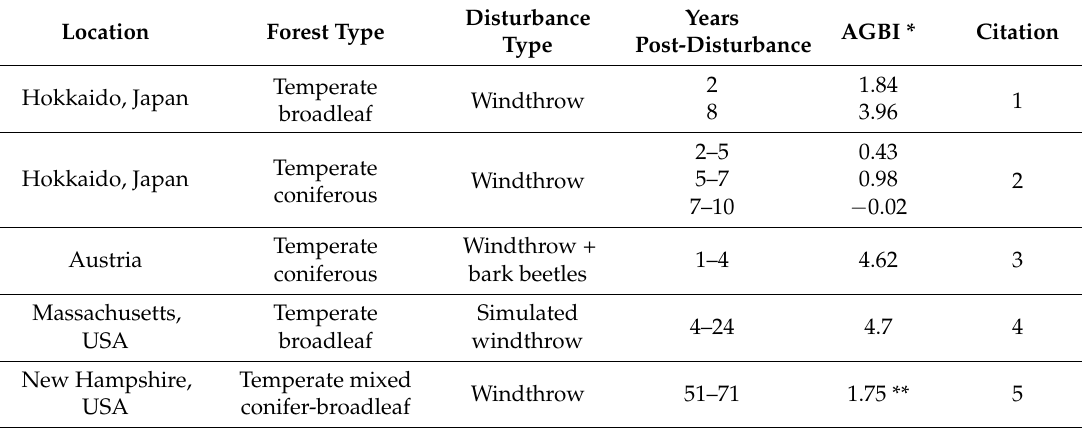
Table 2. Aboveground biomass increment of forests after various